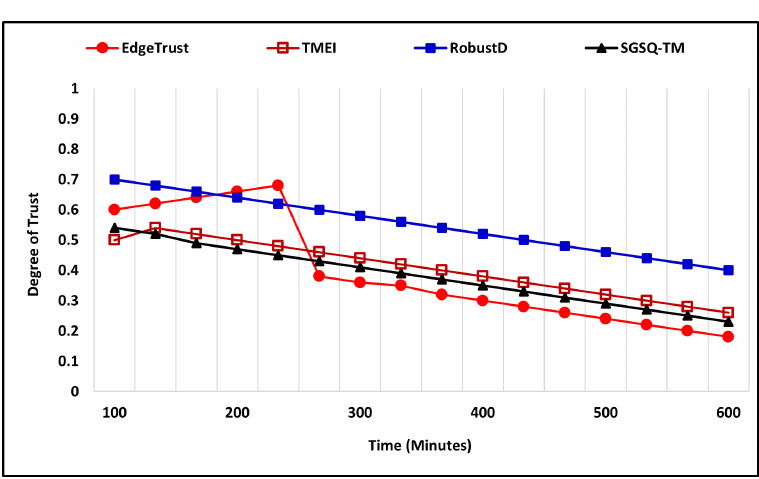
Figure 8. Self-promoting attacks (Scenario-1).